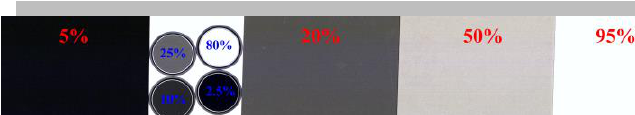
Figure 3. Reference reflectance panels used in the